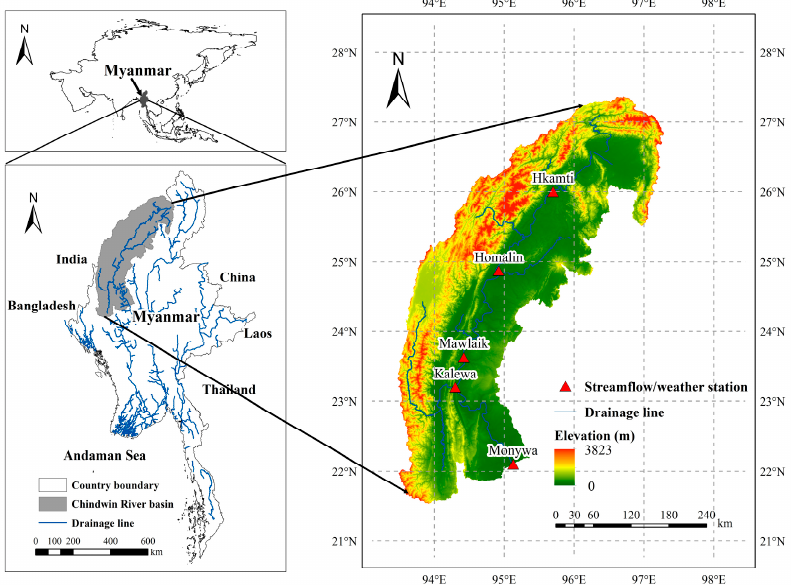
Figure 1. Location of the Chindwin River basin.